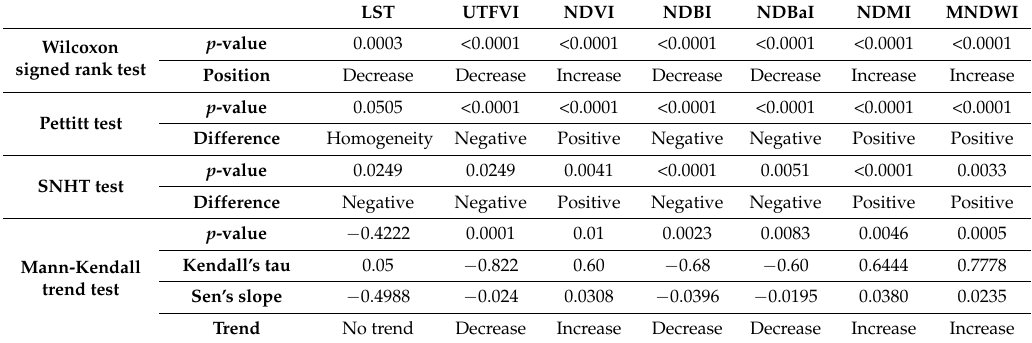
Table 6. Tests results for the Kaplan Park site on selected dates for median LST and spectral indices.